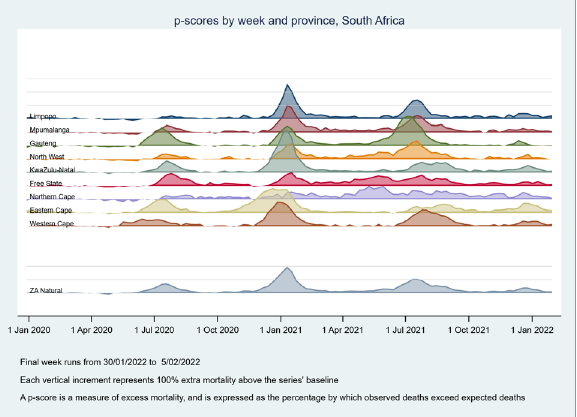
Figure 3: P-score of excess deaths in South Africa by week and province, 29 December 2019 – 5 February 2022.